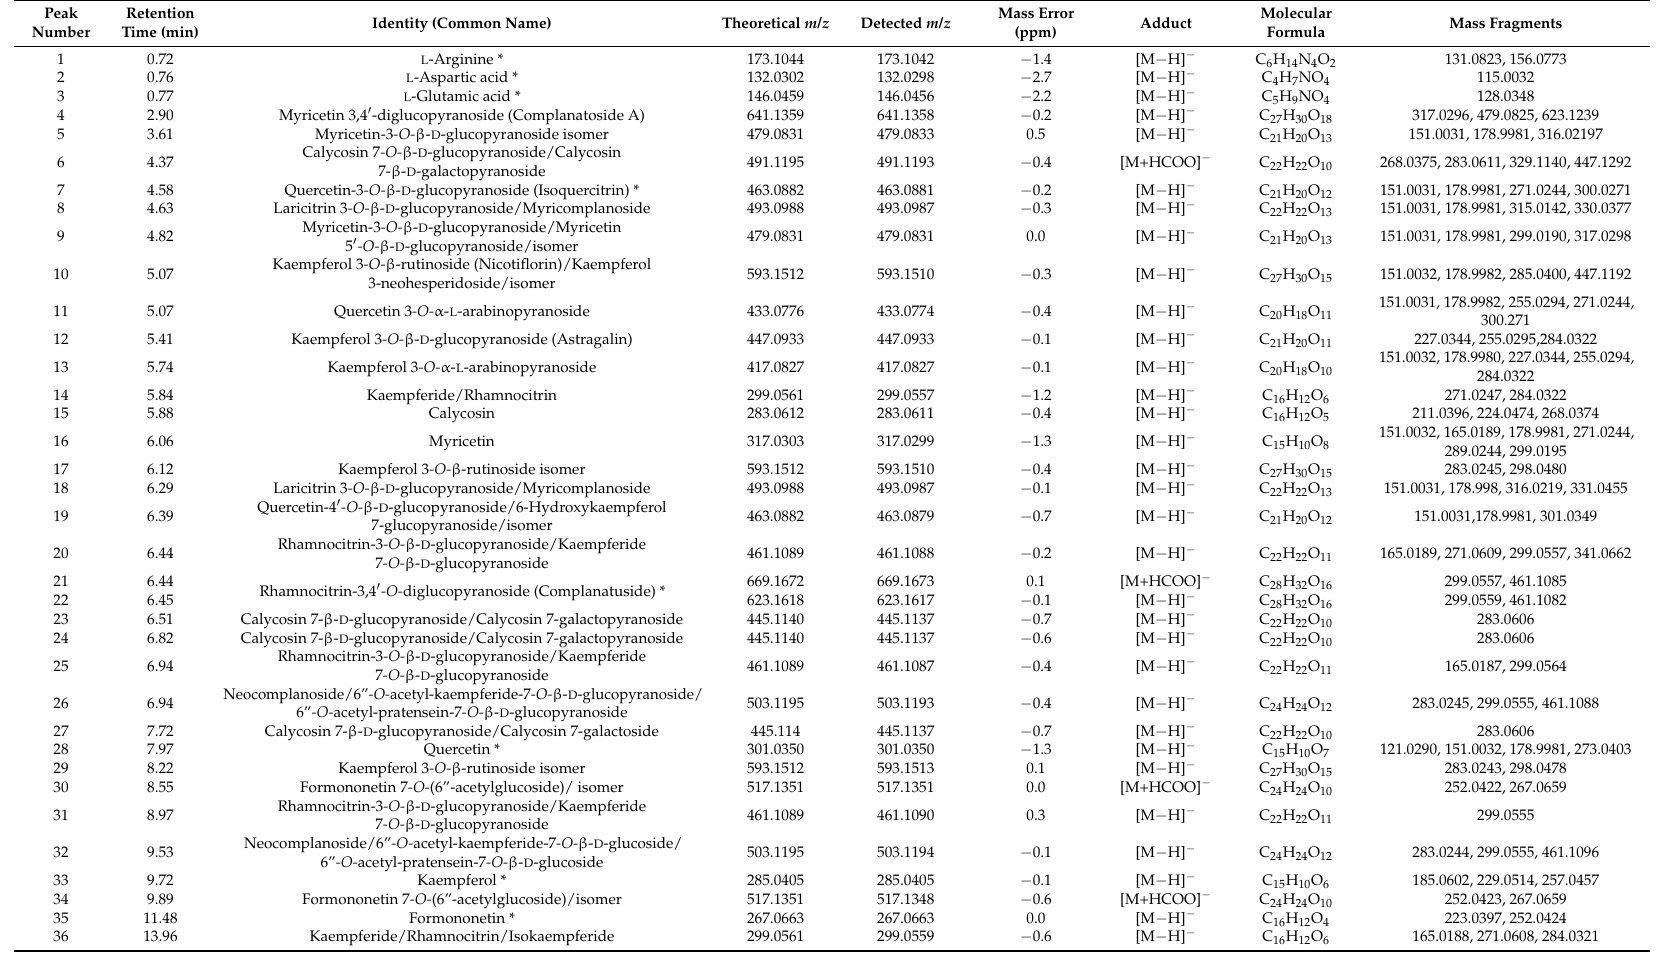
Table 1. Identification of metabolites from 70% ethanol extract of ACS analyzed by